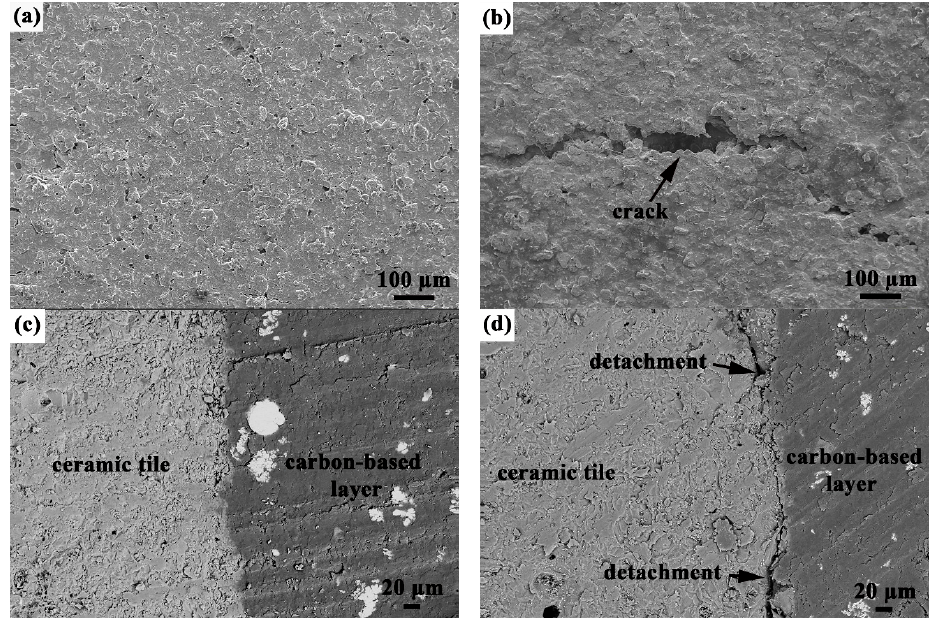
Figure 3. Surface SEM images of the carbon-based layer with suspension thickness of ( a ) 1.0 mm and ( b ) 1.2 mm. Interface backscattering electron images between ceramic tile and carbon-based layer with